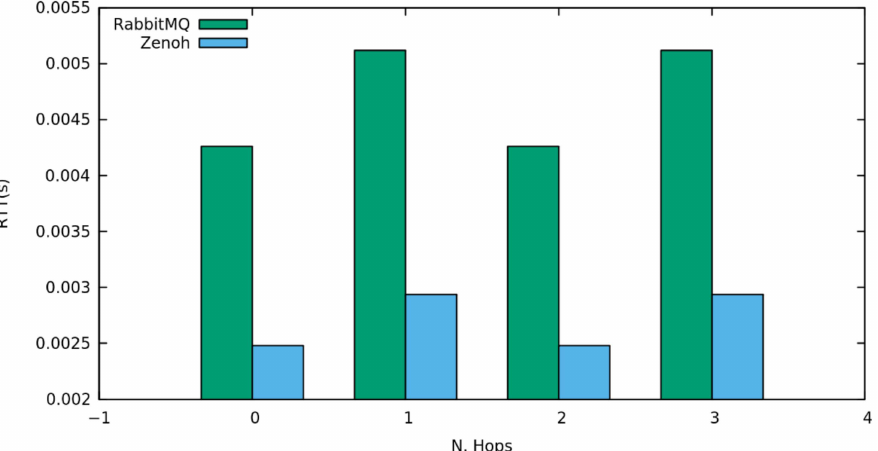
Figure 6. Registered delay in publish/subscribe mechanisms when traversing an increasing number of network hops starting from direct point to point communication to three